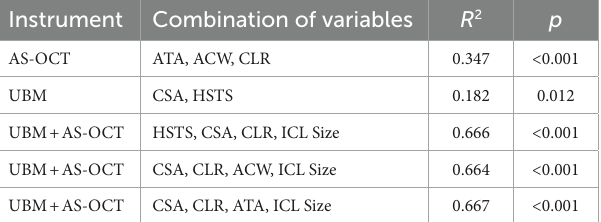
TABLE 3 Multiple linear regression analysis for determining WH formula in the training group.